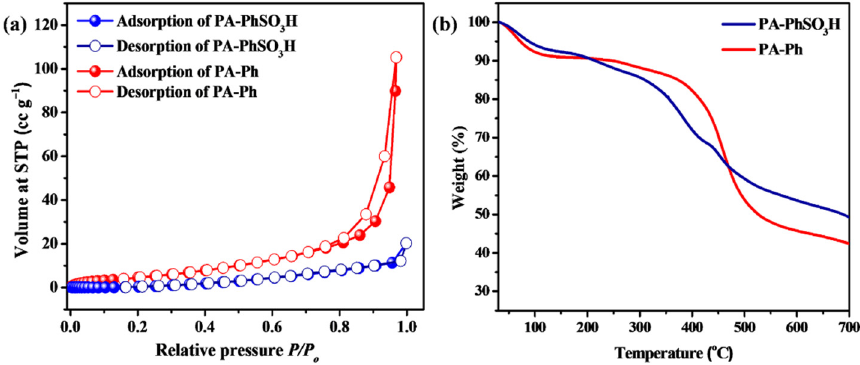
Figure 3. ( a ) N 2 sorption isothermal and ( b ) TGA curves of PA-PhSO 3 H and PA-Ph .